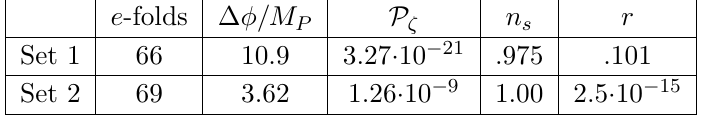
Table 2 . Field range and power spectrum for both parameter